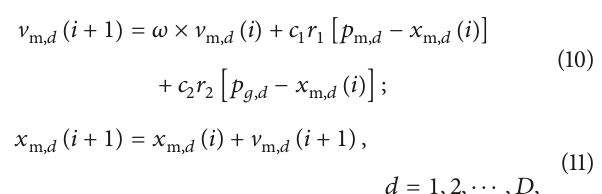
which has three attribute indexes: position, velocity, and fitness. The position represents a possible solution to the optimization problem. The velocity is a vector, which deter- mines the direction and size of iteration. The fitness is used to measure the good or poor position. If evaluation result is poor, then the position should be updated through iteration. Supposing the position vector of the m th particle , ⋅ ⋅ ⋅ , 𝑥 , ⋅ ⋅ ⋅ , 𝑥 ) , then its velocity vector is 𝑋 𝑚 = (𝑥 m ,1 m ,𝑑 m ,𝐷 , ⋅ ⋅ ⋅ , V , ⋅ ⋅ ⋅ , V ) , where D is the number is 𝑉 𝑚 = ( V m ,1 m ,𝑑 m ,𝐷 of dimensions. During every iterative process, the m th particle first searches for its own best solution 𝑝𝑏𝑒𝑠𝑡 𝑚 = , 𝑝 , ⋅ ⋅ ⋅ , 𝑝 ) , that is, the individual extreme value. (𝑝 m ,1 m ,2 m ,𝐷 Then, all particles find the group best solution gbest = , 𝑝 , ⋅ ⋅ ⋅ , 𝑝 ) , that is, the global extreme value. When (𝑝 g ,1 g ,2 g ,𝐷 the fitness corresponding to the global extreme value satisfies the error requirement, the iteration reaches convergence and the global extreme value is obtained as the optimal solution. Otherwise, the velocity and position are iteratively updated according to the method shown in (10) and